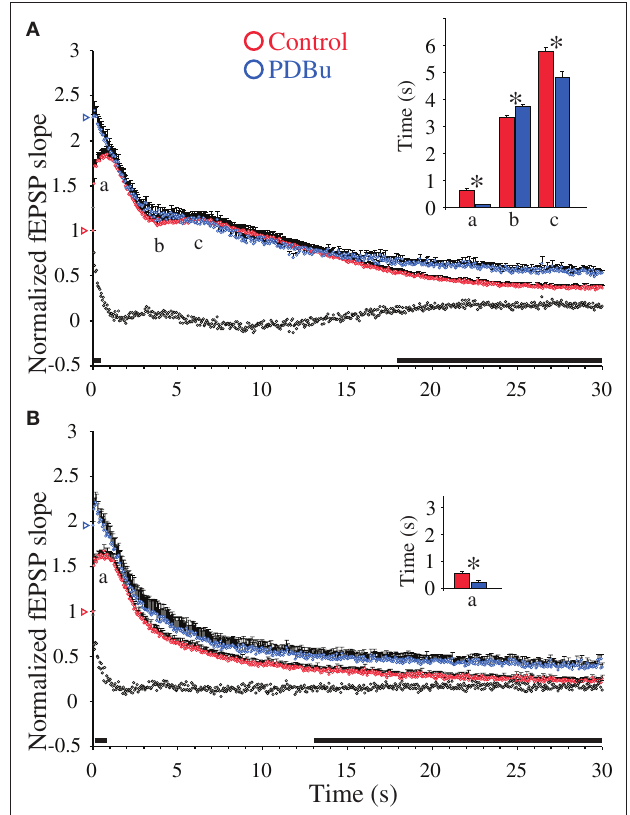
Figure 3 | Phorbol ester-induced synaptic enhancements during 20 Hz stimulation in hippocampal excitatory CA3-to-CA1 synapses. (A) Normalized fEPSP slope measurements from CA3-to-CA1 synapses during 20 Hz stimulation in slices ( n = 17) from WT mice treated with β -phorbol-12,13- dibutyrate (PDBu, 10 µ M, blue symbols) and in experiments without PDBu ( n = 22, red symbols). Vertical bars indicate S.E.M. Subtractions of the values without PDBu from those obtained with PDBu present are represented by the black, open symbols. The black horizontal bar along the abscissa indicates p < 0.05 when comparing the two situations. Colored open triangles on the ordinate point to the starting value for the different conditions. a Indicates time point of the maximum magnitude of the initial frequency facilitation; b time to the transition point between the initial frequency facilitation and the DRE; c time needed to reach the peak of the DRE. The average measurements from individual experiments are shown in inset histogram with corresponding colored vertical bars. Vertical bars indicate S.E.M. * p < 0.05 when compared to the control situation. (B) As in (A) but the slice experiments are from DKO mice treated with PDBu (10 µ M, blue symbols; n = 17) compared to experiments without PDBu ( n = 18, red